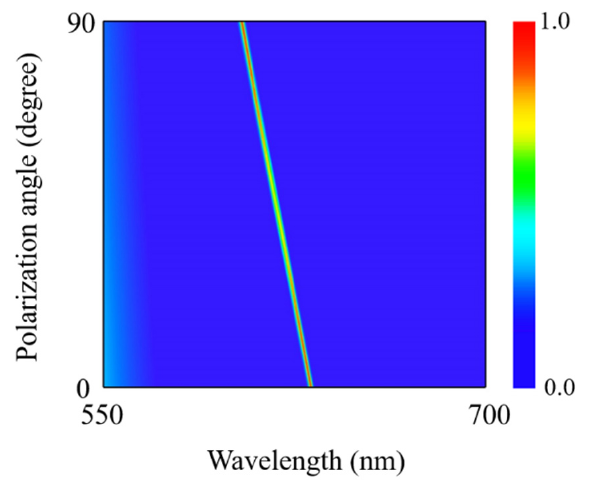
Figure 5. Absorption spectra of the proposed structure as a function of wavelength and polarization angle of incident light. P = 500 nm, w = 40 nm, t = 105 nm, and h = 300 nm.